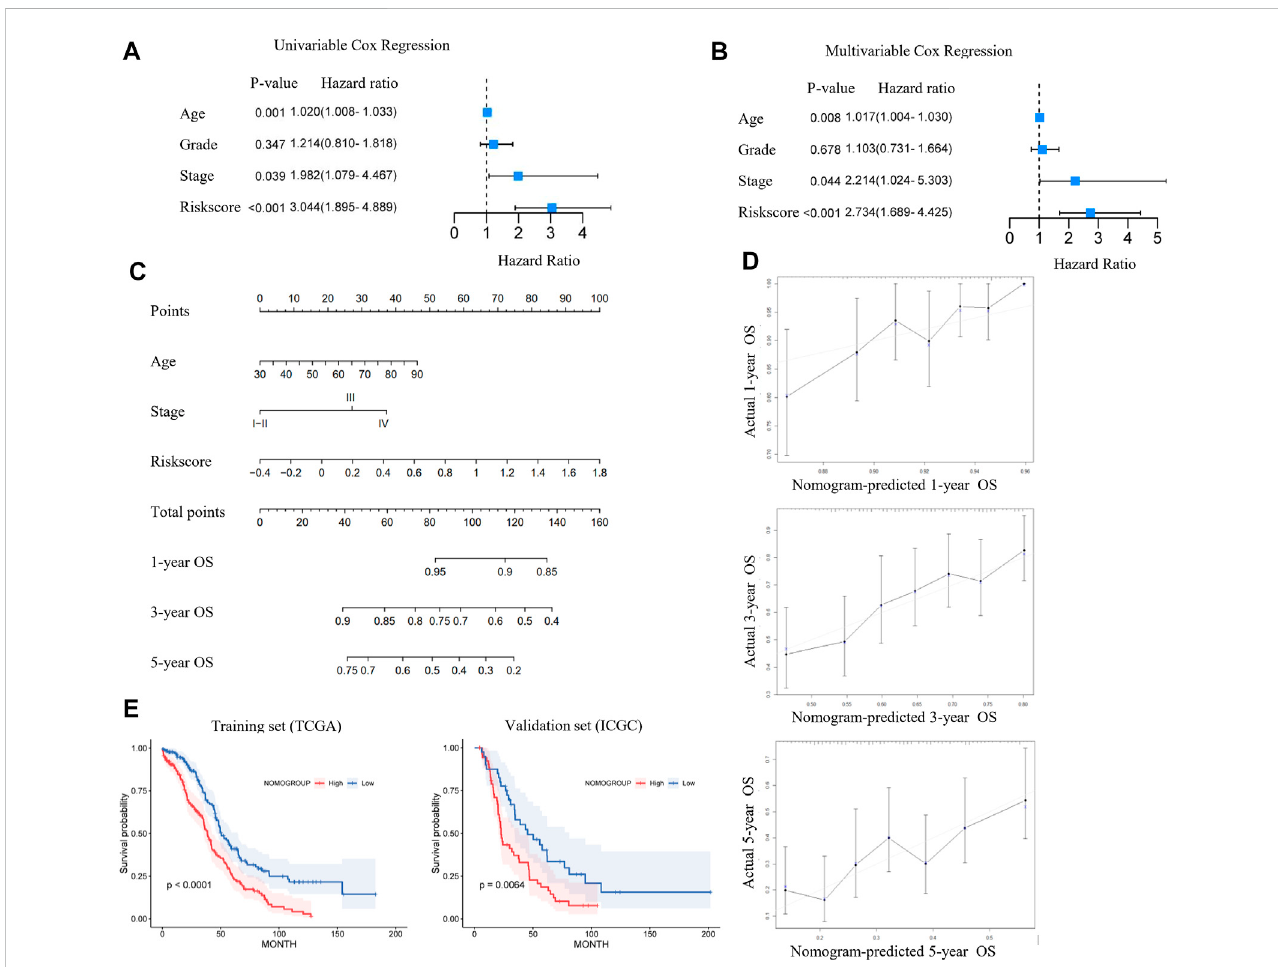
FIGURE 5 Construction and validation of the ferroptosis-associated three-gene-based nomogram. The forest plot of univariate (A) and multivariate (B) Cox regressionanalysisforovariancancer(OV)patientsurvival,basedonthe3-genesignatureandclinicalfeatures. (C) TheNomogrammodeloftheriskscoreand clinical indicators for predicting 1-year, 3-year, and 5-year OS of OV patients in the TCGA cohort. (D) The calibration plots of the nomogram for predicting 1- year(top),3-year(middle),and5-year(bottom)OSofOVpatients.Thedottedlineindicatedtheactualsurvival. (E) TheKaplan-Meier(K-M)curvesforOV patients in the training (TCGA) and validation cohort (ICGC), strati fi ed by the nomogram